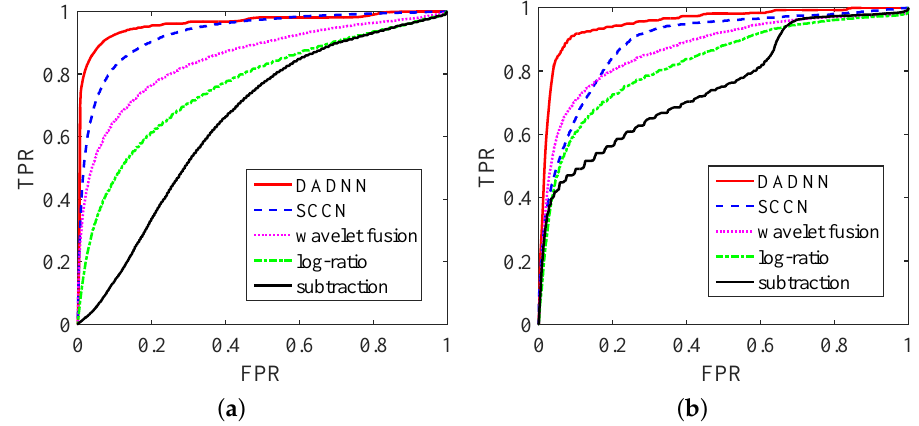
Figure 20. The DIs generated by different methods in the Yellow River data set: DI generated by ( a ) subtraction, ( b ) log-ratio, ( c ) wavelet fusion, ( d ) SCCN, and ( e ) DADNN.